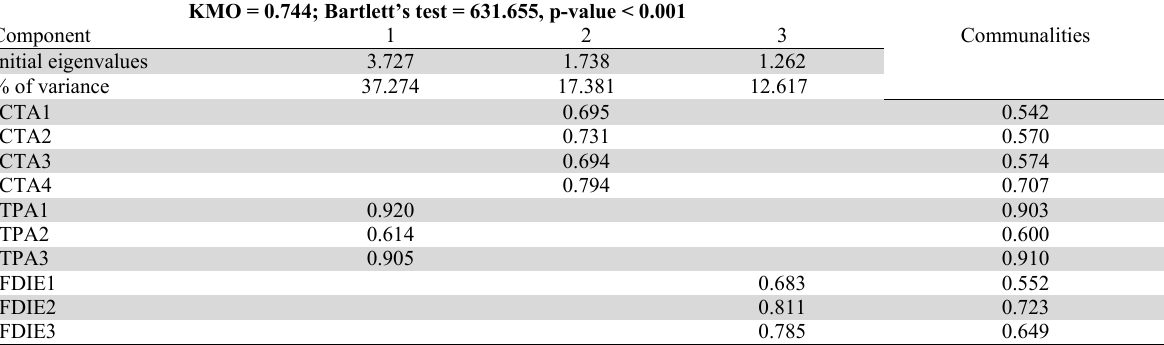
EFA Analysis result after Varimax rotation